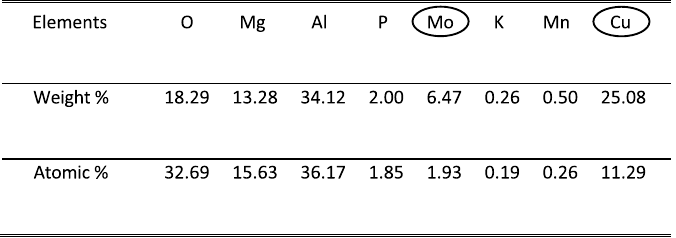
Table 2 The chemical composition of the oxide layer after three-step